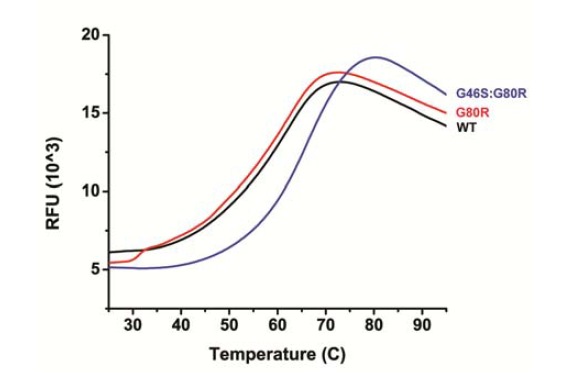
DOI:
http://dx.doi.org/10.7554/eLife.21646.024